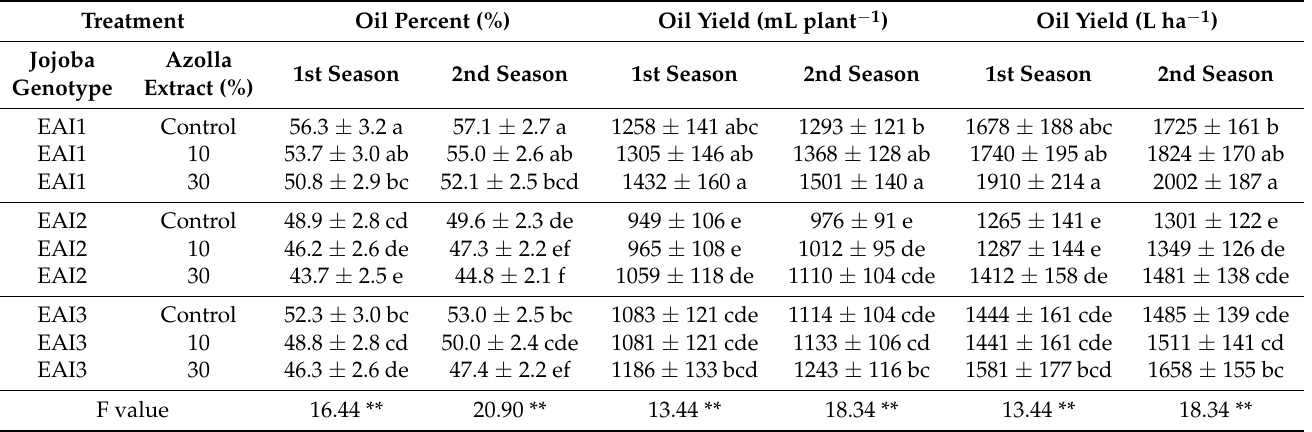
same column. Table 5. In both seasons of the study, the mean values of oil percent (%), oil content (mL plant − 1 , and oil yield (L ha − 1 ) of jojoba shrubs as influenced by combined treatments of plant genotypes and foliar application of Azolla filiculoides Lam. plant